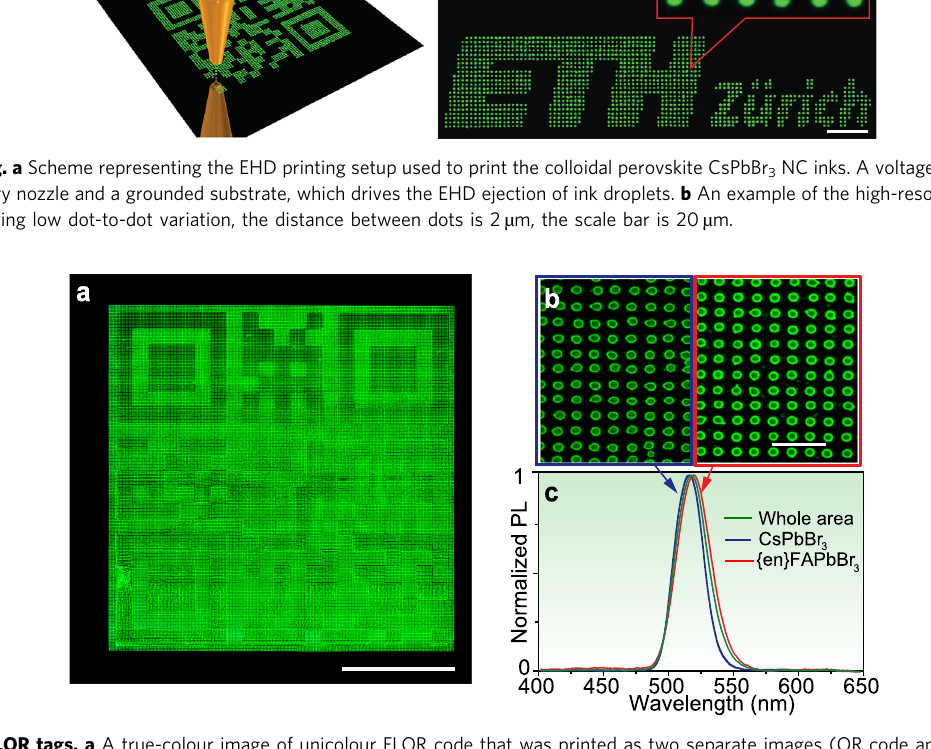
Fig. 4 Unicolour FLQR tags. a A true-colour image of unicolour FLQR code that was printed as two separate images (QR code and its inverse) from perovskite NC inks (scale bar is 800 µ m); b zoomed-in image of a containing regions of CsPbBr 3 (blue) and {en}FAPbBr 3 (red) inks (scale bar is 30 µ m). c The spatially resolved PL spectra from the corresponding regions of (blue and red rectangles on b), whose PL spectra overlap to form one apparent emission band